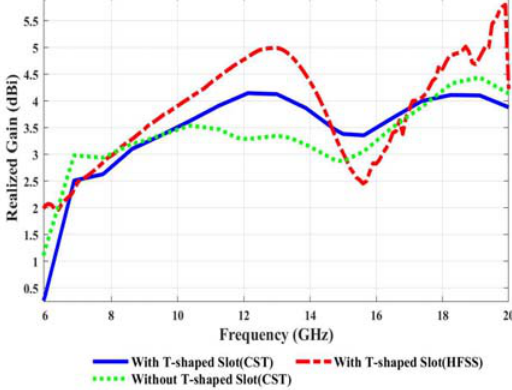
Fig. 6. Simulated realized gain of the proposed flower- shaped